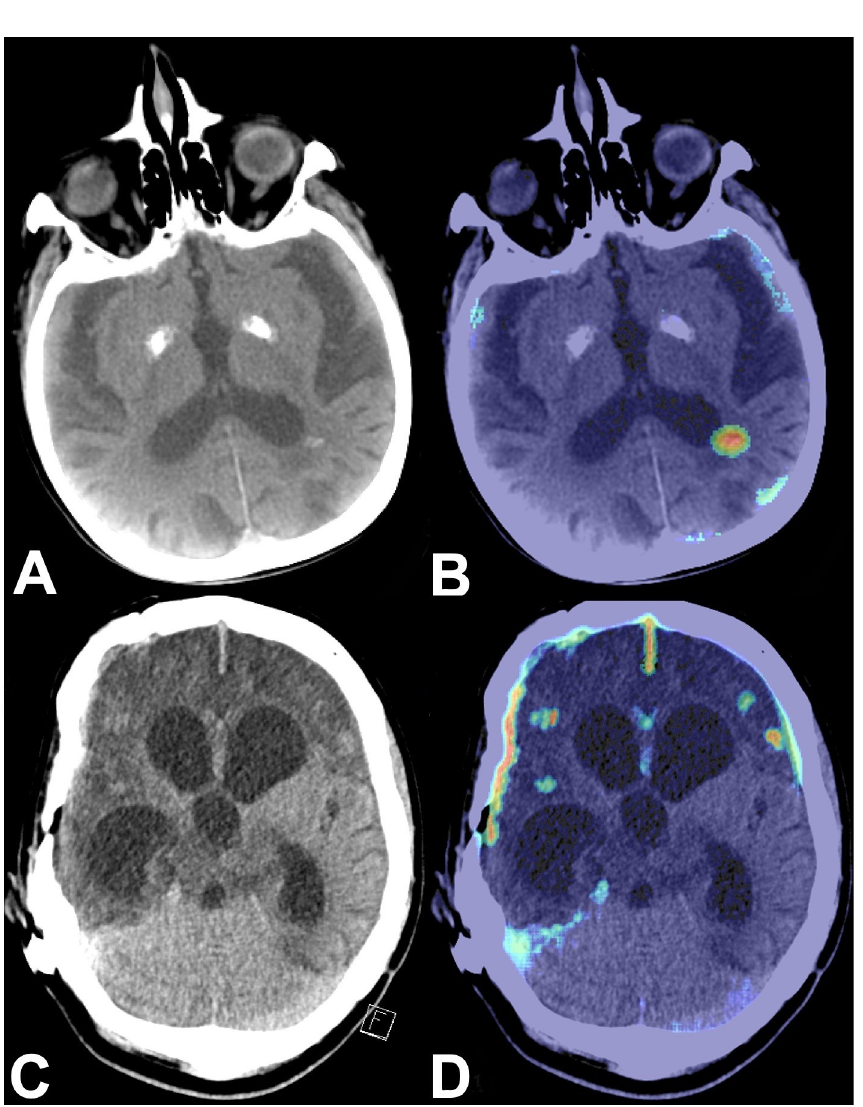
Enlarged ventricles and hypodense parenchyma after non-traumatic SAH. Hyperdense appearance of the frontotemporal dural patch. B and D: Corresponding color-coded maps flagging uncommon calcifications (B), dural patch, falx, tentorium, and residual parenchyma in both the frontal and the right temporal lobes (D) (HCT, head computed tomography; SAH, subarachnoid